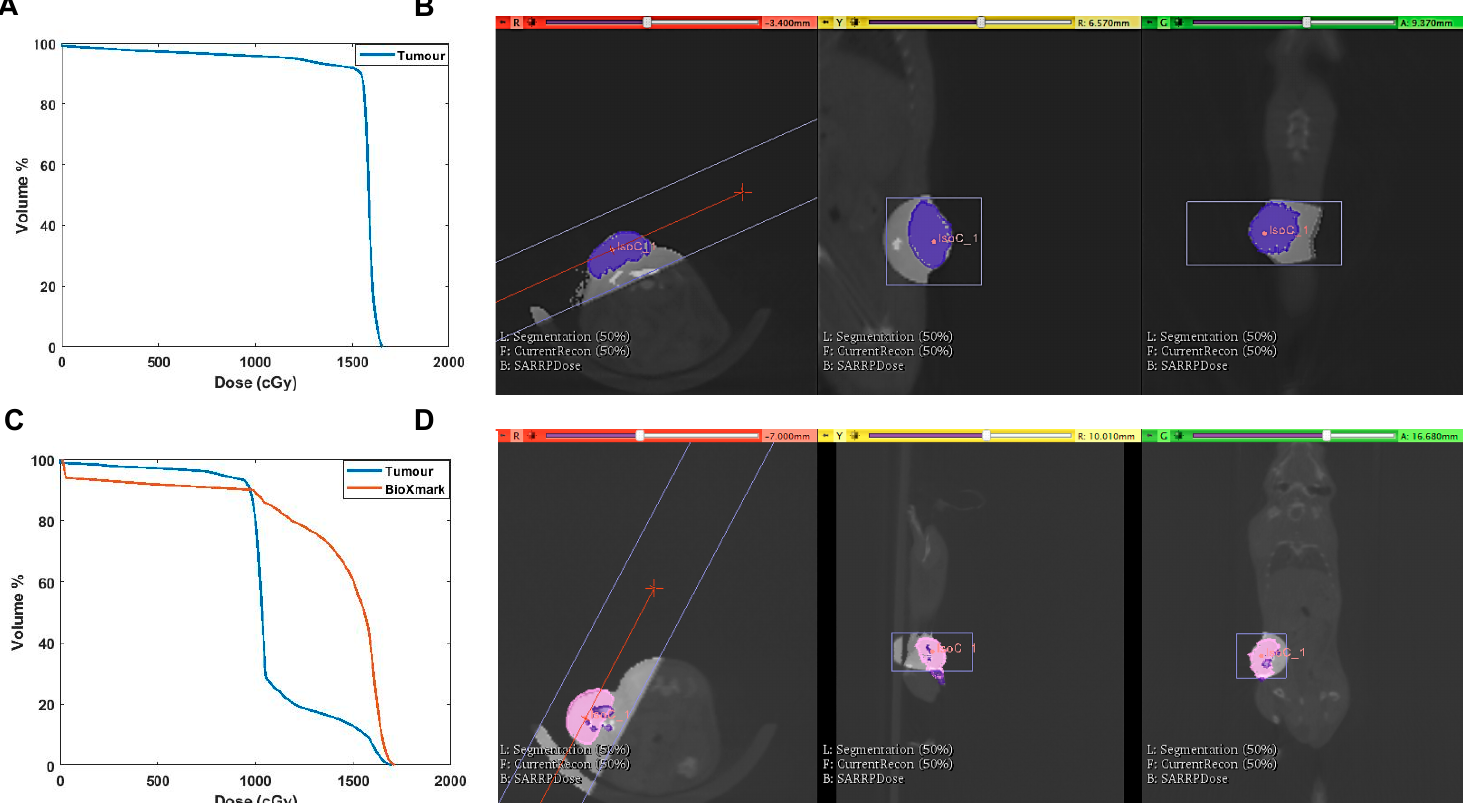
Figure 5. Evidence of underdosing of LLC tumour due to intratumoral injection of BioXmark ® . ( A ) Dose volume histograms (DVHs) of tumours receiving 16 Gy single-dose irradiation. ( B ) Corresponding treatment plan from Muriplan of CBCT scan of mouse with tumour tissue contoured in blue. ( C ) DVH outlining dose received by tumour tissue and BioXmark ® at 16 Gy single-dose irradiation. ( D ) Corresponding treatment plan from Muriplan showing CBCT scan of mouse, with tumour contoured in pink and intratumoral injection of BioXmark ® in purple.